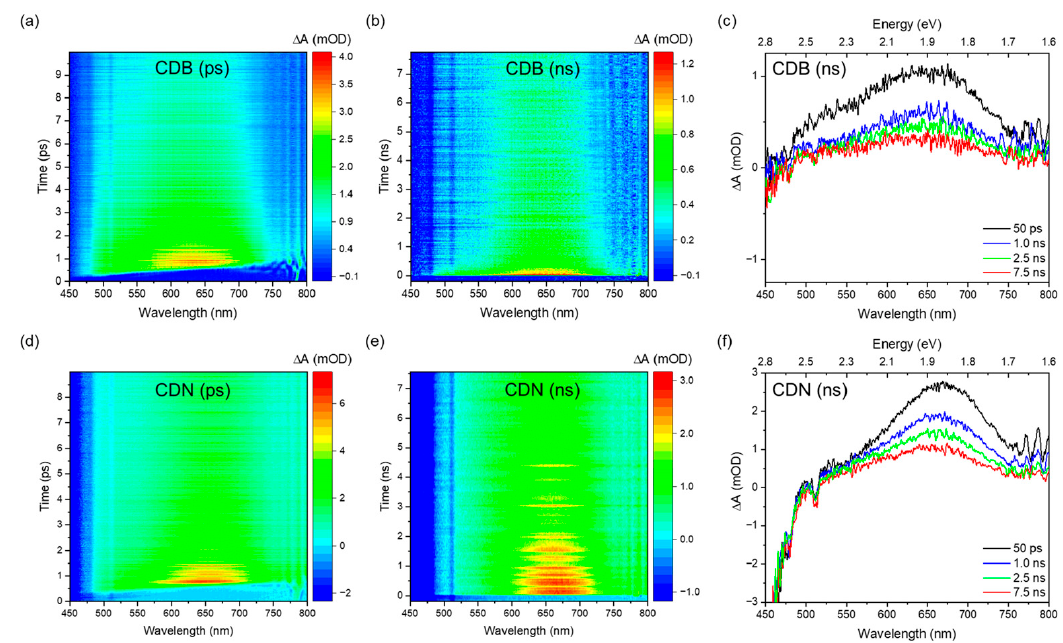
Figure 5. Time-wavelength TA plot of CDB ( top ) and CDN ( bottom ) samples in water solution in the picosecond range ( a , d ), in the nanosecond range ( b , e ), and TA signals at selected delay times ( c , f ).